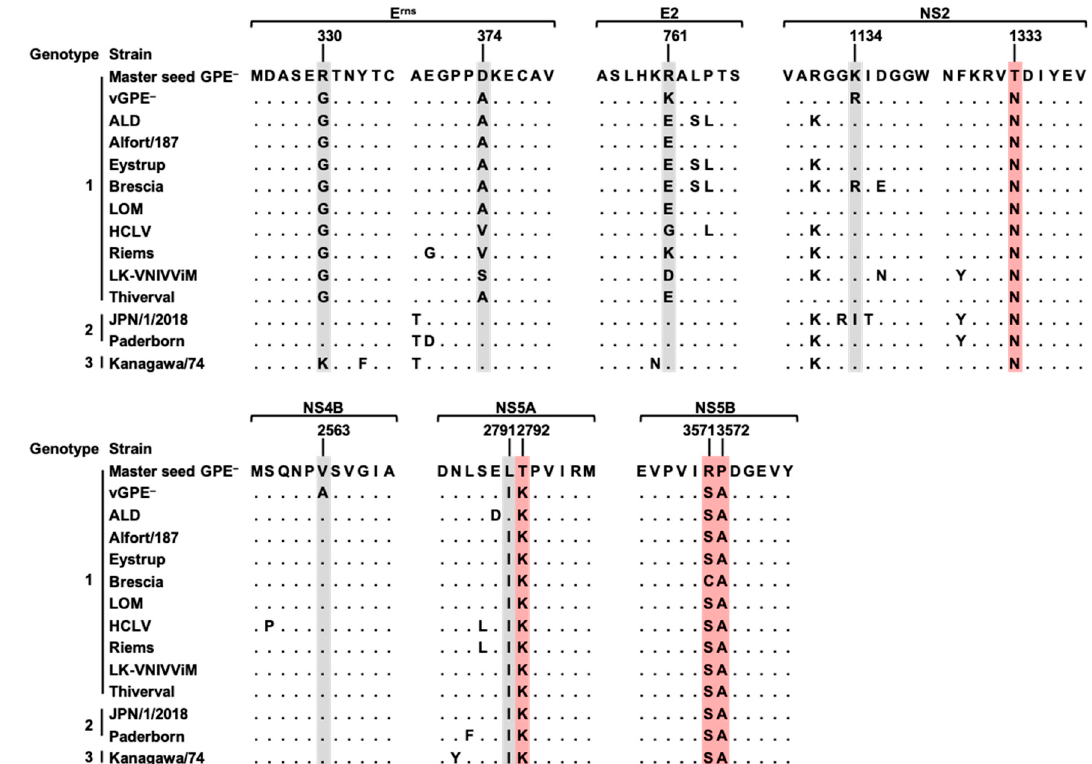
Figure 3. Amino acid alignment of substitution sites among CSFV strains. The amino acid sequences of 10 substitution sites and their contexts of selected CSFV strains are aligned. The sites of amino acid substitution are highlighted in gray. The amino acid sequences unique to the master seed GPE − are highlighted in red.